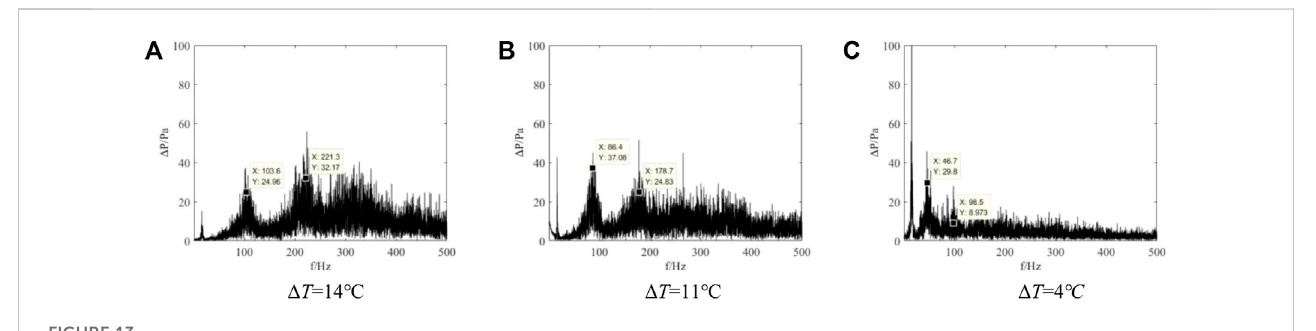
no longer subjected to large-scale collapse condensation, and the position resolution between the main steam area and the downstream steam column is not obvious. The fi rst dominant